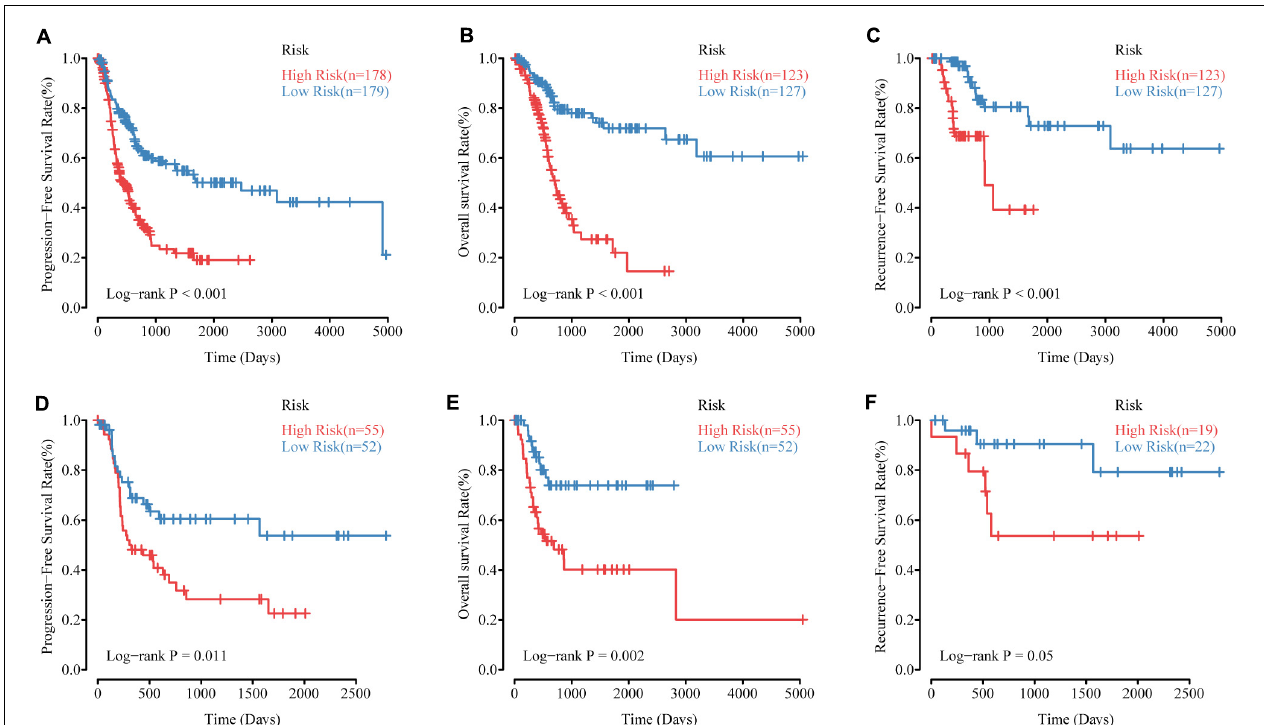
FIGURE 4 | The performance of MRSB in predicting progression, survival and recurrence. (A) Progression-free survival in all patients. (B) Overall survival in the training cohort. (C) Recurrence-free survival in the training cohort. (D) Progression-free survival in the validation cohort. (E) Overall survival in the validation cohort. (F) Recurrence-free survival in the validation cohort. MRSB, methylation risk score for bladder cancer.